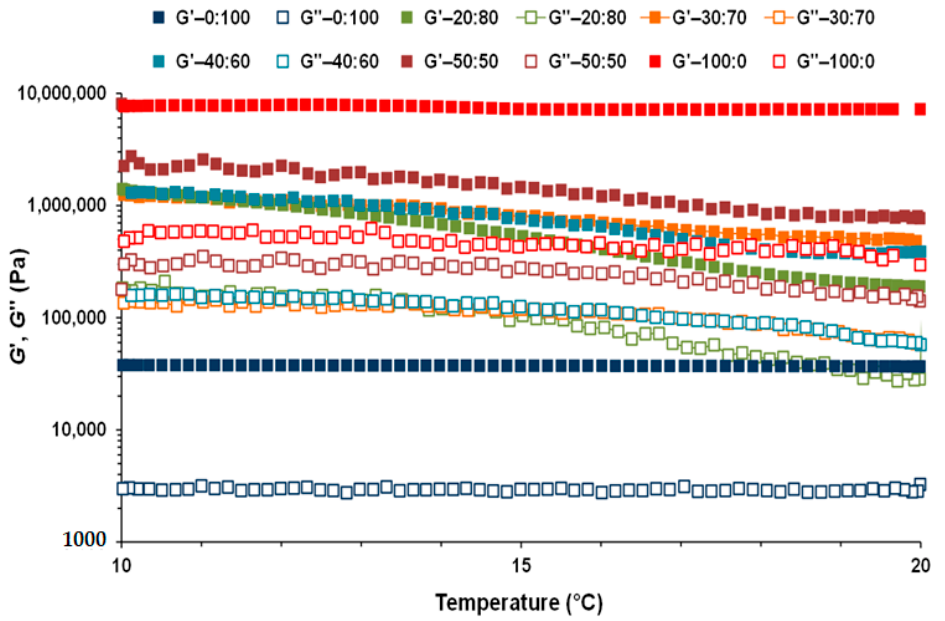
Figure 3. Storage modulus ( G ': filled squares) and loss modulus ( G ": open squares) as a function of temperature 20 and 10 °C for the different formulated CB:OG systems.